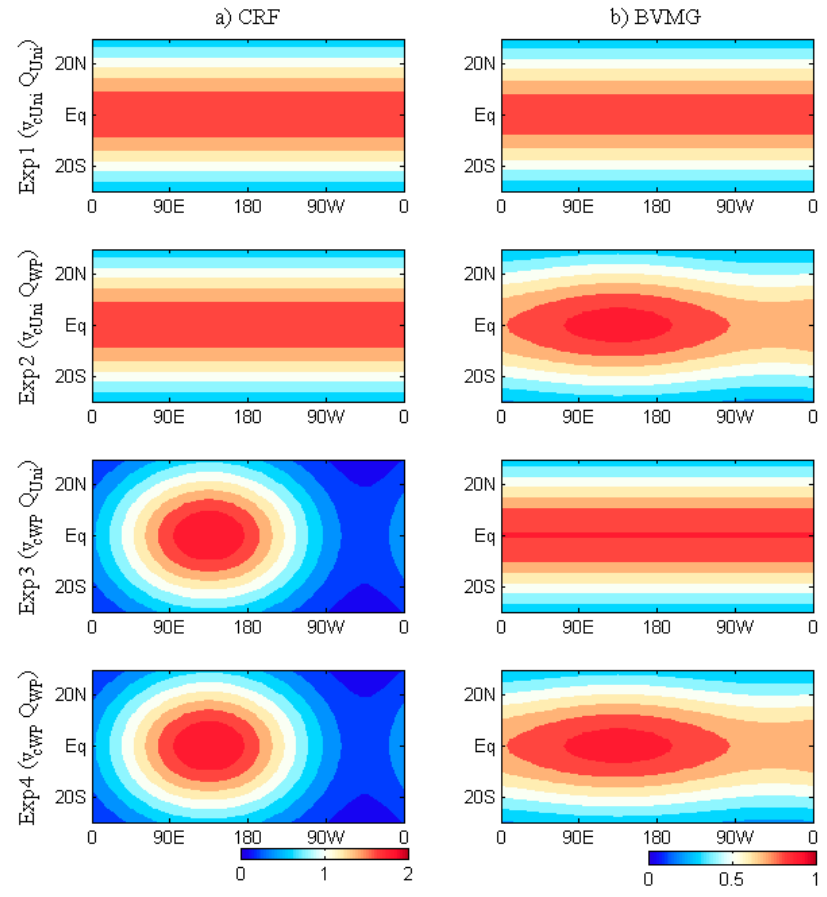
Figure 6. Mean states of four sensitivity experiments: ( a ) the CRF (day − 1 ); and ( b ) the non-dimensional tropospheric BVMG used in the four experiments (Exp 1, Exp 2, Exp 3, and Exp 4). In Exp 1, zonally uniform CRF and BVMG are used, while the Warm Pool-like mean state is used in Exp 4. In Exp 2 and Exp 3, the zonally uniform and Warm Pool-like pattern are used for these two fields, respectively.